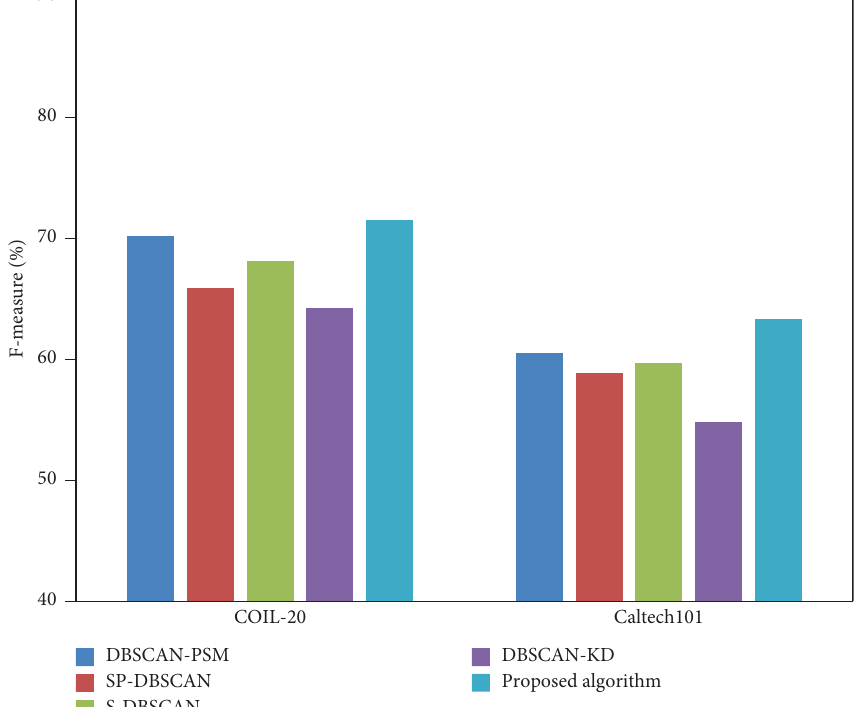
Figure 10: Comparison of clustering accuracy of diferent algorithms in image